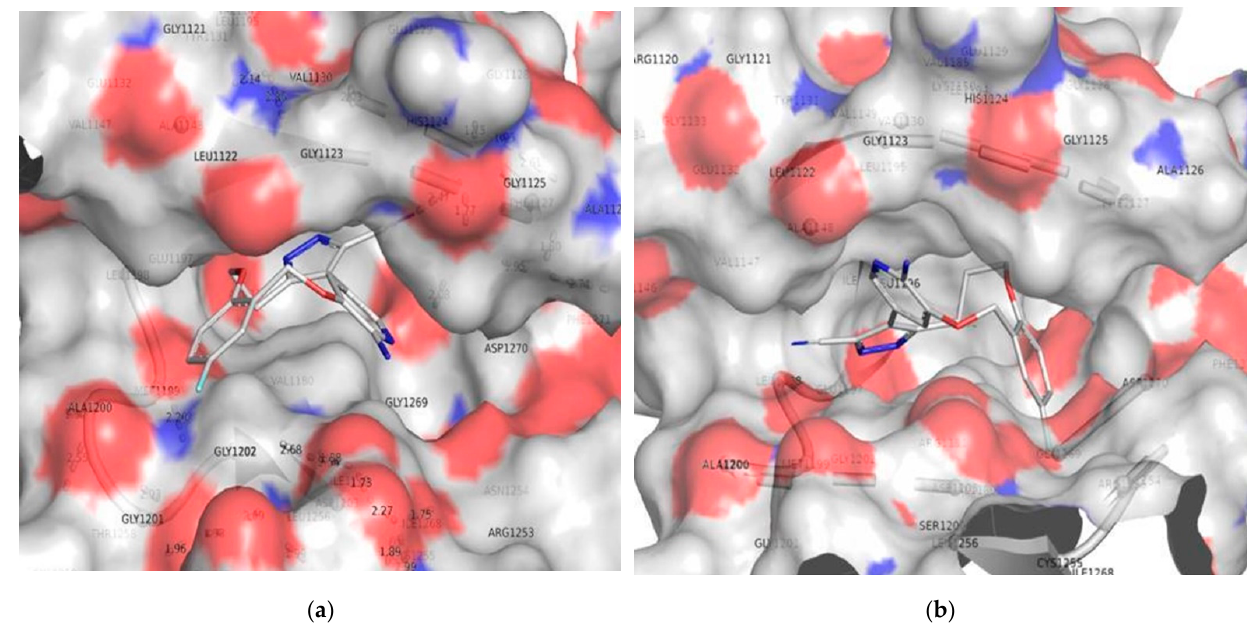
Figure 10. Depiction of the docking pose for the molecules 171 ( a ) and 172 ( b ) within the binding pocket of the ALK tyrosine kinase.